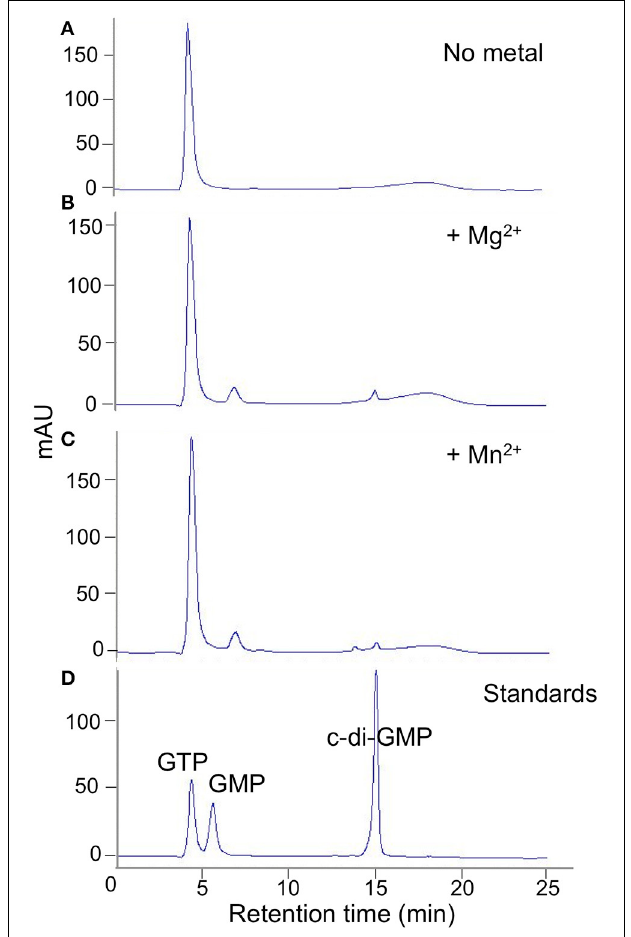
FIGURE 3 | DVU2067 has very low DGC activity. HPLC traces for diguanylate cyclase assay with purified DVU2067. Purified DVU2067 (with C-terminal V5 epitope and 6X-His tags) was mixed with 500 μ M GTP in the presence of (A) no metal; (B) 2mM MgCl 2 ; (C) 2mM MnCl 2 ; and incubated for 40h. A mixture of 100 μ M GTP, 100 μ M GMP, and 100 μ M c-di-GMP were run as standards (D)